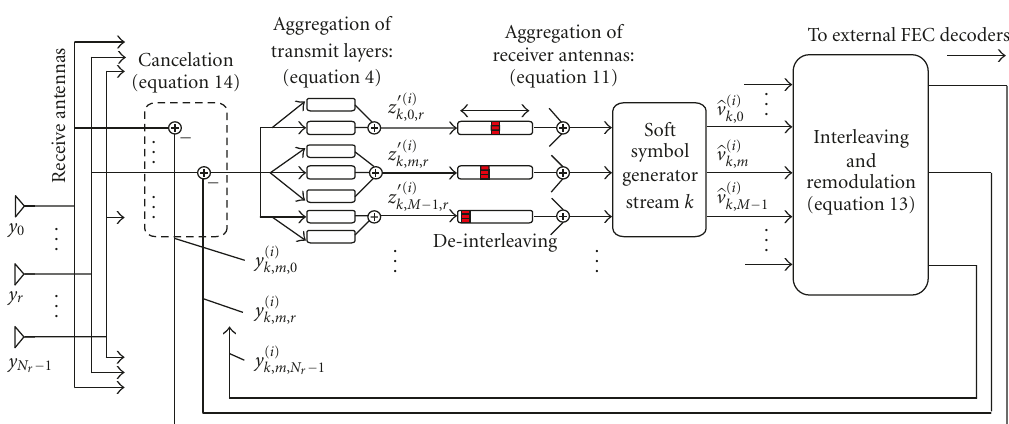
Figure 2: Signal flow chart of the partitioned receiver highlighted for stream k and antenna r